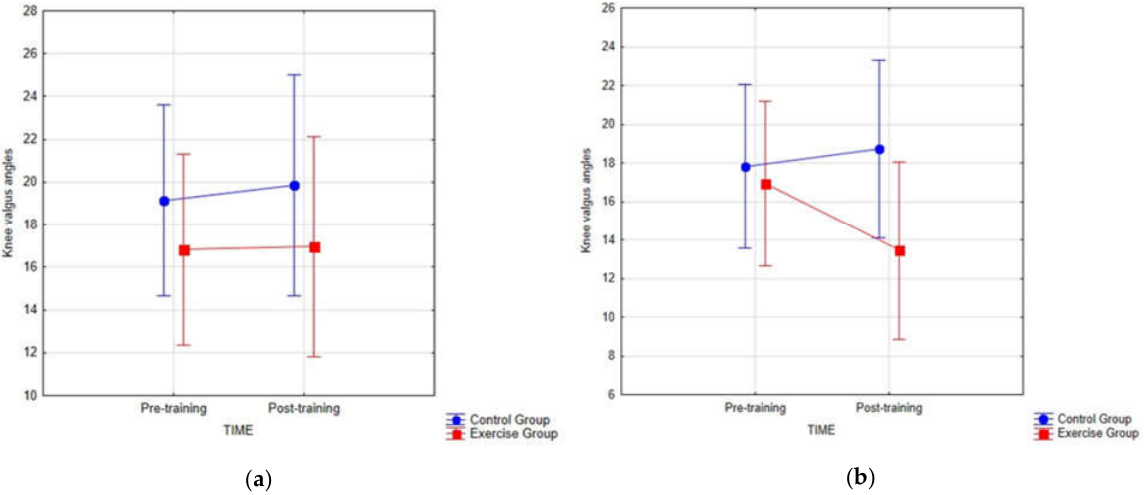
Figure 4. Mean with SD (°) for both groups at Pre-training and Post-training for the ( a ) right knee valgus, and ( b ) left knee valgus angles.